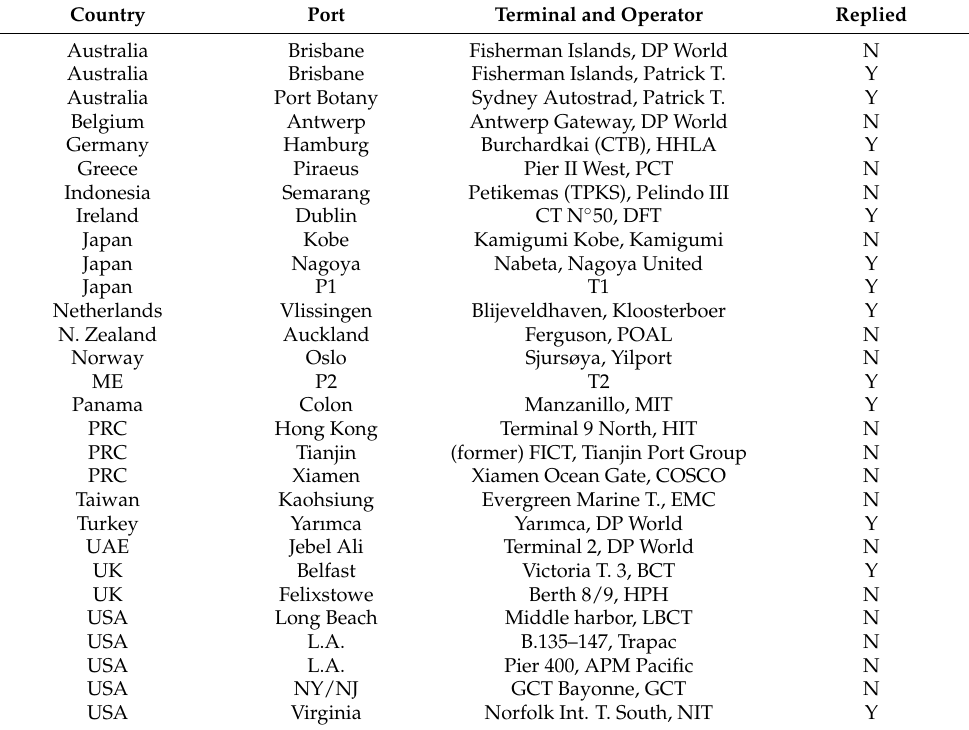
Table 1. Sample of terminals studied and